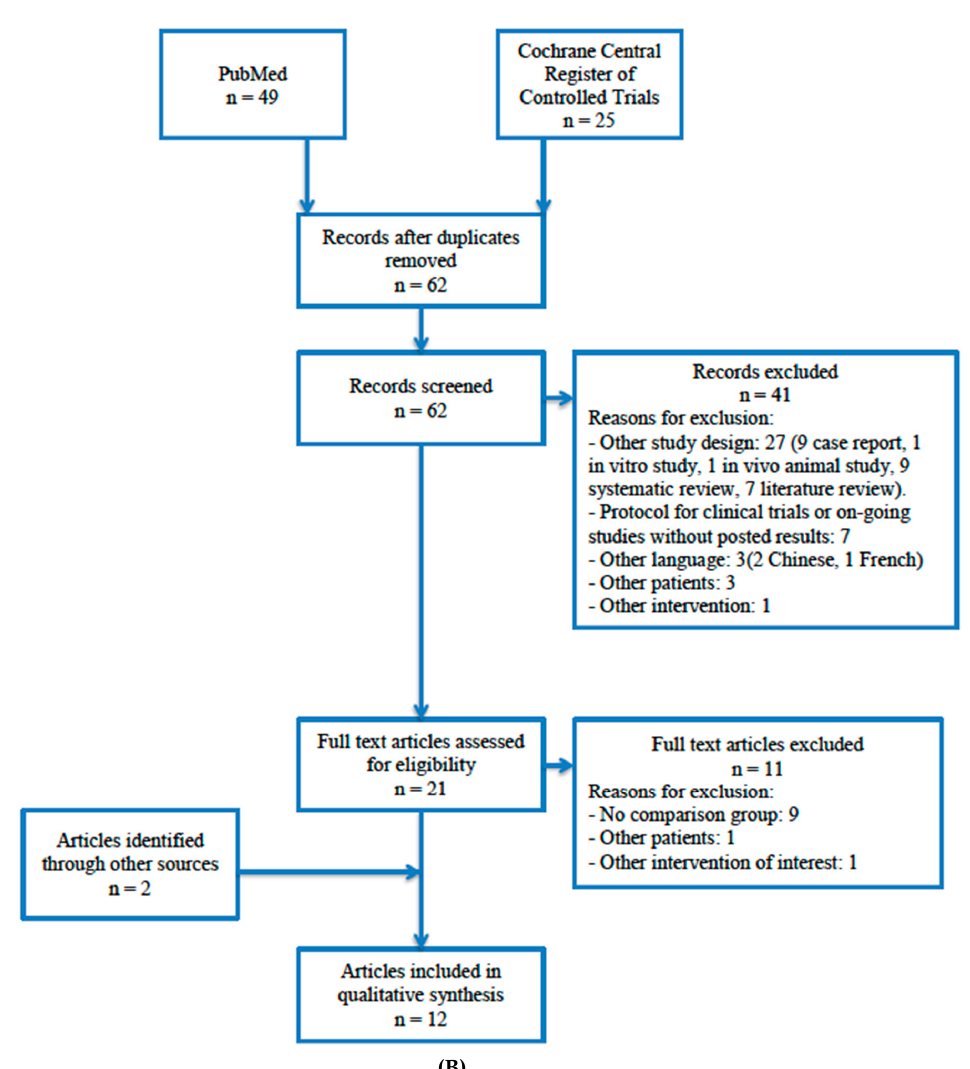
Figure 1. (A) Diagram for study selection: sole use of platelet concentrates in sinus floor augmentation. ( B) Diagram for study selection: platelet-rich fibrin (PRF) in combination with other ( B) Diagramforstudyselection: platelet-richfibrin(PRF)incombinationwithothergraftingbiomaterials grafting biomaterials in sinus floor augmentation. in sinus floor